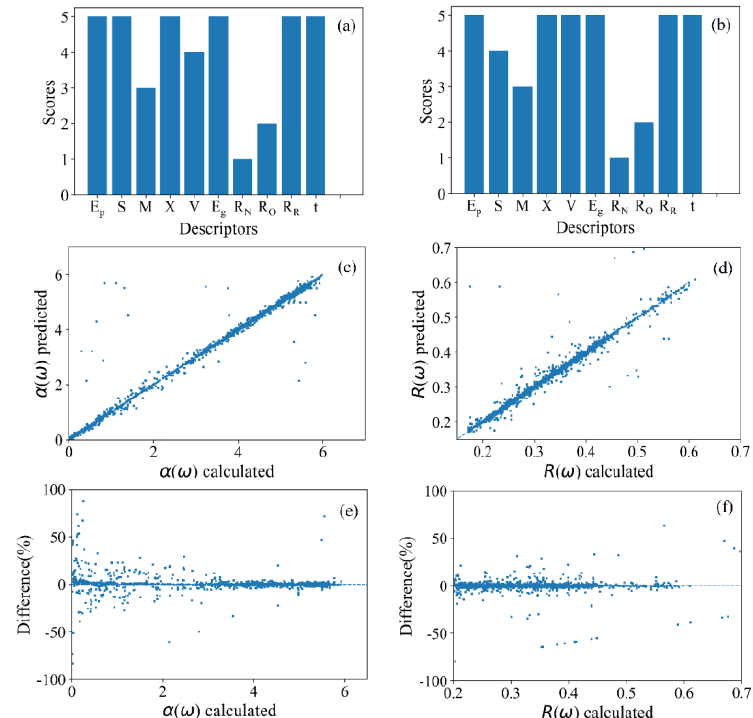
Figure 5. Scores of the absorption model descriptors evaluated using RFE methodology ( a ). Scores of the reflectivity model descriptors evaluated using RFE methodology ( b ). Comparison between absorption coefficient calculated by VASP and absorption coefficient predicted by this model ( c ). Comparison between reflectivity calculated by VASP and reflectivity predicted by this model ( d ). Difference between absorption coefficient calculated by VASP and absorption coefficient predicted by this model ( e ). Difference between reflectivity calculated by VASP and reflectivity predicted by this model ( f